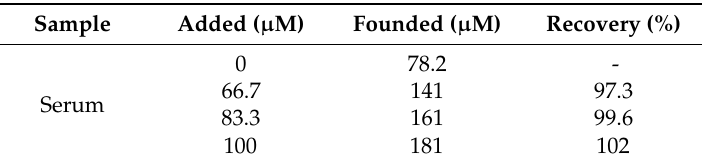
Table 3. Analytical results of GSH in FBS serum sample.